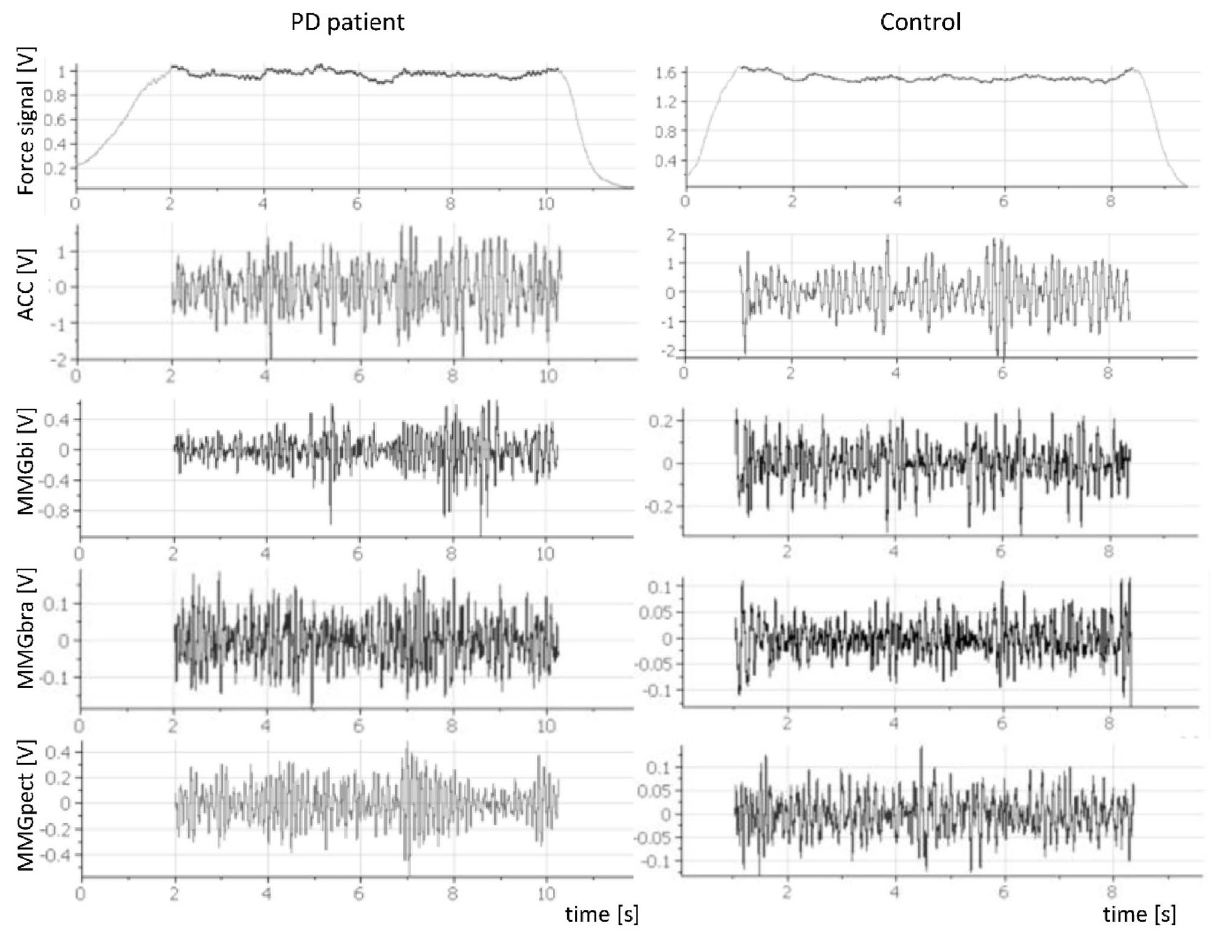
Figure 2. Exemplary raw signals of one PD patient and one control. The left panels display the raw signals of force, ACC, MMGbi, MMGbra, MMGpect of the left side of a PD patient during one trial of the unilateral task at 70% of the MVIC, the right panels illustrate the same signals of one participant of the control group. The dark area in the force signals indicates the isometric